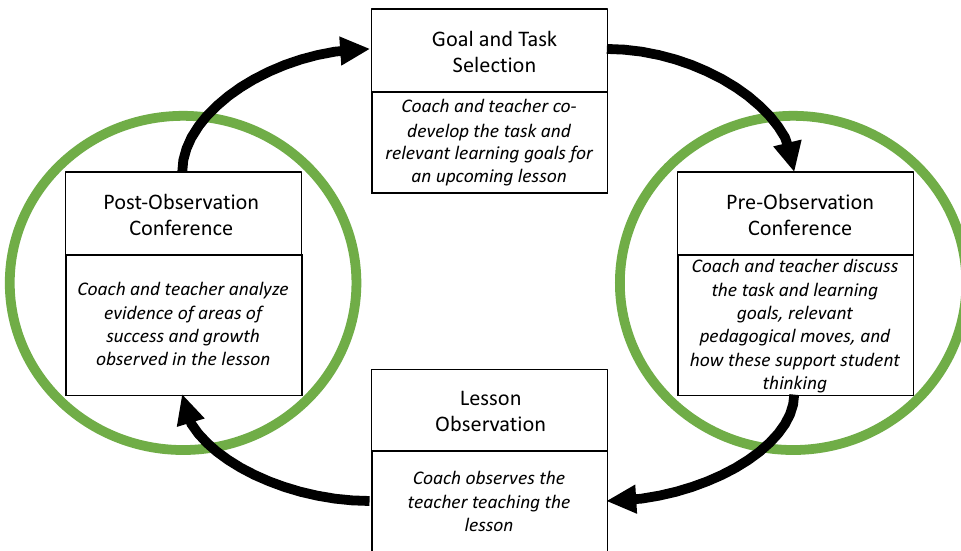
Fig. 1 An overview of the coaching cycle (circles indicate the analytic focus of the current